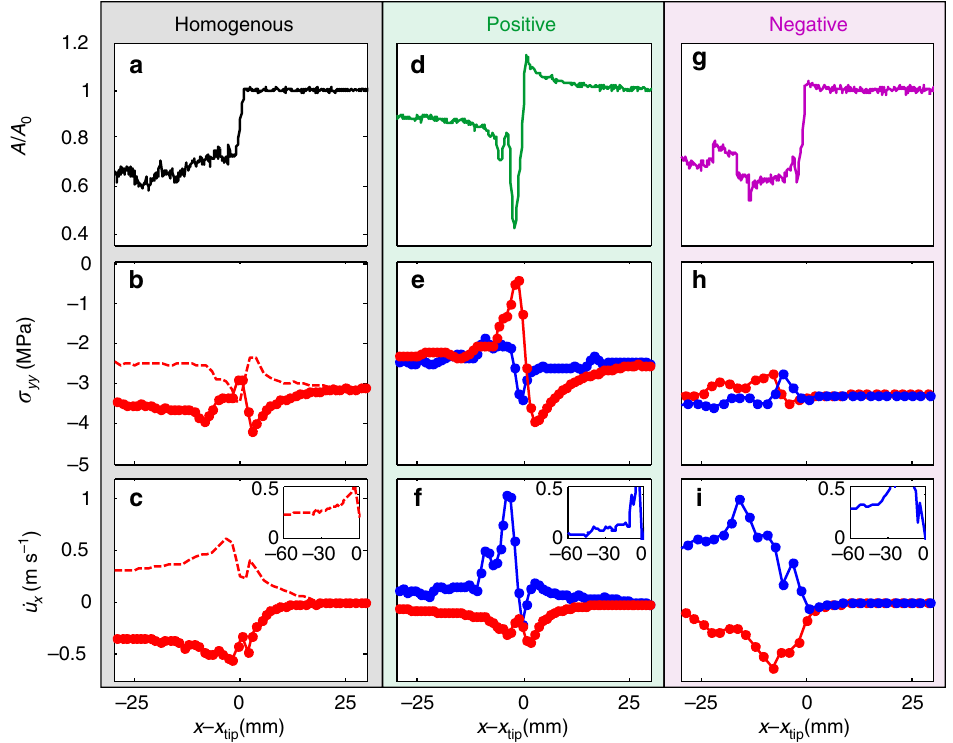
Figure 2 | Contact area and normal stress and particle velocity measurements indicate slip-pulses in the positive direction and supershear cracks in the negative one. Comparisons of contact area, A ( x , t ) ( a , d , g ), normal stresses, s yy ( t ) ( b , e , h ), and particle velocities, _ u x , ( c , f , i ) for the ruptures presented in Fig. 1b. Signs of _ u x correspond to the motion directions denoted in Fig. 1a. Line colours represent measurements within the different blocks: red lines denote measurements within the stiff material (PMMA) and blue measurements within the compliant material (PC). ( a – c ) Homogenous interface, x tip ¼ 109mm: (red dashed line) top block, (solid line) bottom block. Bimaterial interfaces, ( d – f ) positive direction, x tip ¼ 125mm and ( g – i ) negative direction, x tip ¼ 87mm. Ruptures along the positive direction are characterized by highly localized signals compared with those in the homogenous and negative directions. Insets in c , f and i : _ u x measurements for (cid:2) 60 o x (cid:2) x tip o 0 demonstrate slip localization solely in the positive direction. Line colours in d and g correspond to the rupture propagation directions denoted in Fig.